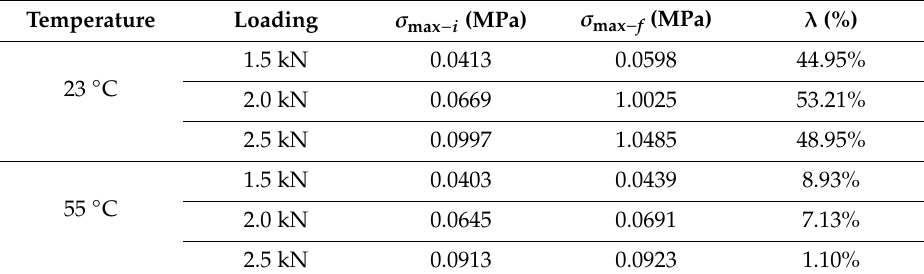
Table 3. Maximum tensile principle stress under di ff erent conditions.